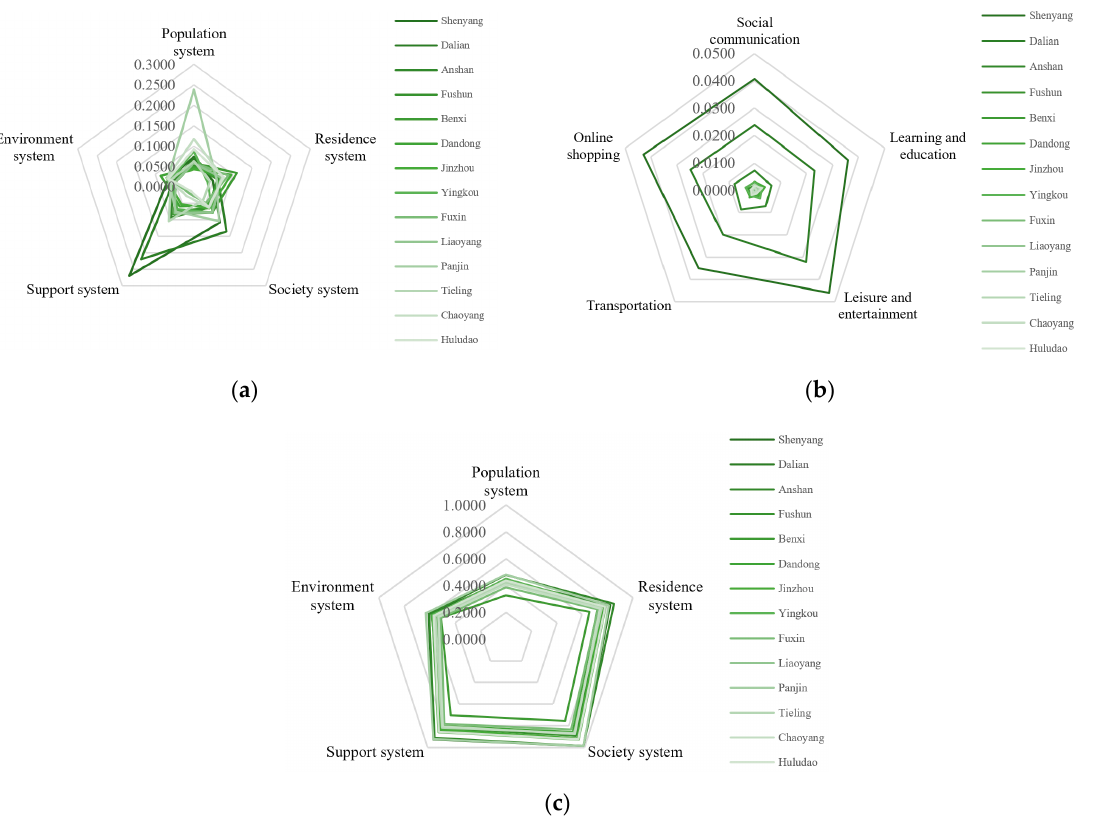
Figure 6. ( a ) RHSs system score radar map; ( b ) PHSs system score radar map; ( c ) IHSs system score radar map.